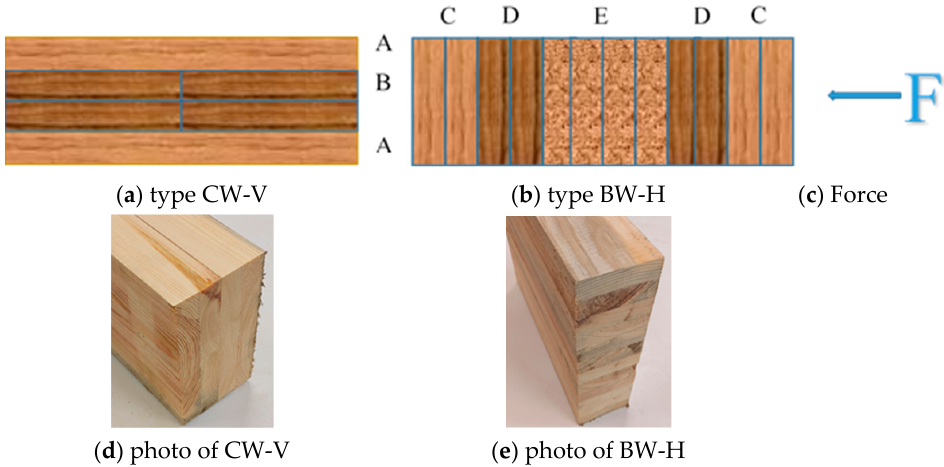
Figure 1. Sawn timber arrangement in the manufacture of structural beams (A,B,D,E), C—direction of loading; (( a )—quality in the bend test, ( b )—waste timber, unclassified, ( c )—visual assessment-class KW, ( d )—visual assessment-class KS, ( e )—visual assessment-class KG). For each piece of wide sawn timber (over 100 mm), their linear dimensions, density